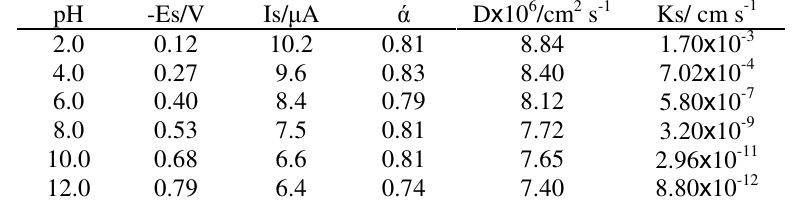
Table 3. Typical A.C. polarographic data of fluchloralin concentration 0.5 mM, Drop time: 3s